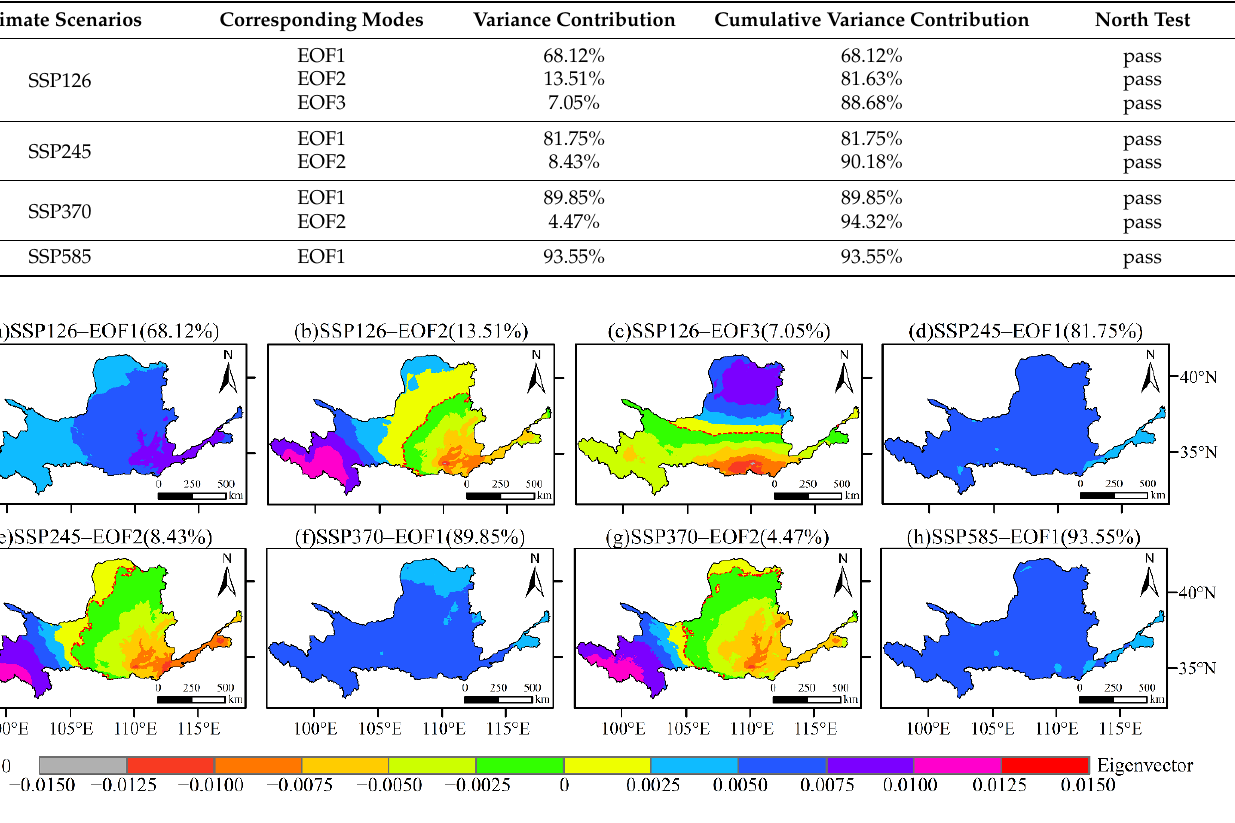
Figure 10. Main modal eigenvectors of the EOF of the ET 0 spatial field in the Yellow River Basin for 2022–2100 under scenarios SSP126 ( a – c ), SSP245 ( d , e ), SSP370 ( f , g ), and SSP585 ( h ), where SSP126/245/370/585–EOFi (contribution/%) in each figure represents the i-th modal eigenvector (EOFi) of ET 0 under scenarios SSP126/245/370/585, with the contribution of each mode in parenthe- ses. The red dashed lines in ( b , c , e , g ) are the positive and negative dividing lines of the